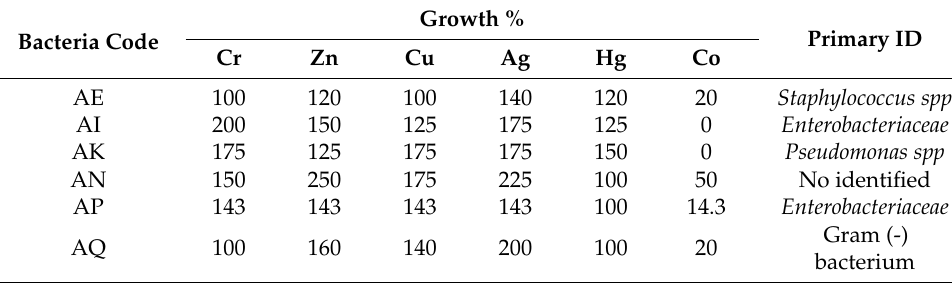
Table 2. Bacterial strains isolated and percentage of growth in metals